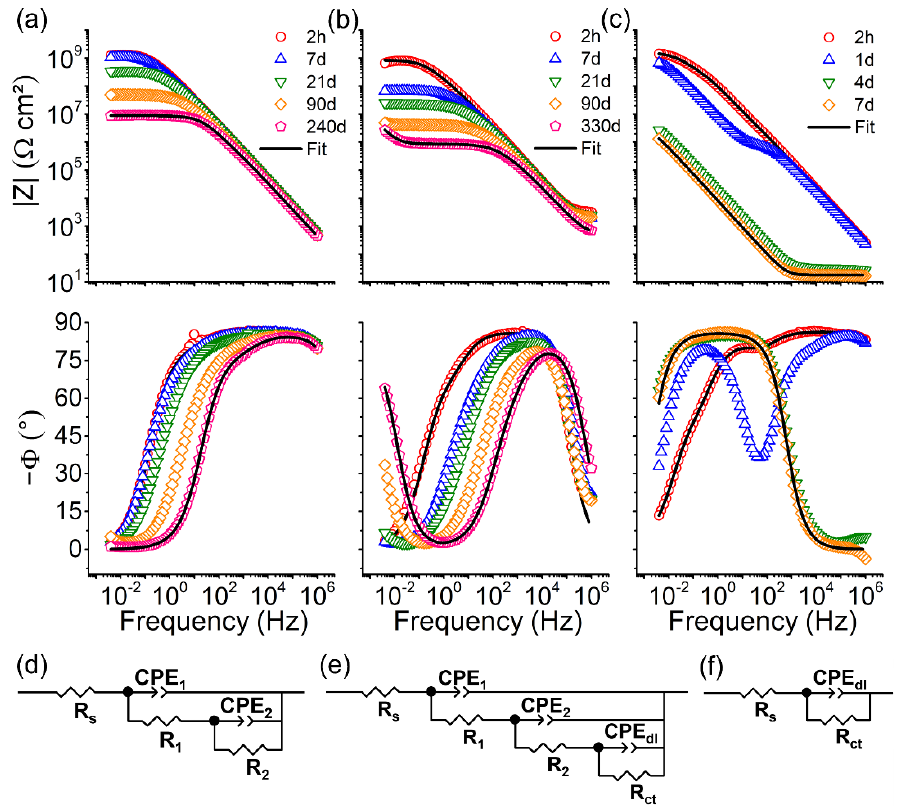
Figure 7. Bode plots for epoxy – silica hybrid coating prepared with DETA/DGEBA = 0.4 as a function of immersion time in: ( a ) 3.5 wt.% NaCl, ( b ) SCPS1 (pH 8), and ( c ) SCPS2 (pH 14) solution. ( d – f ) Equivalent electrical circuits (EEC) used to fit the EIS data.